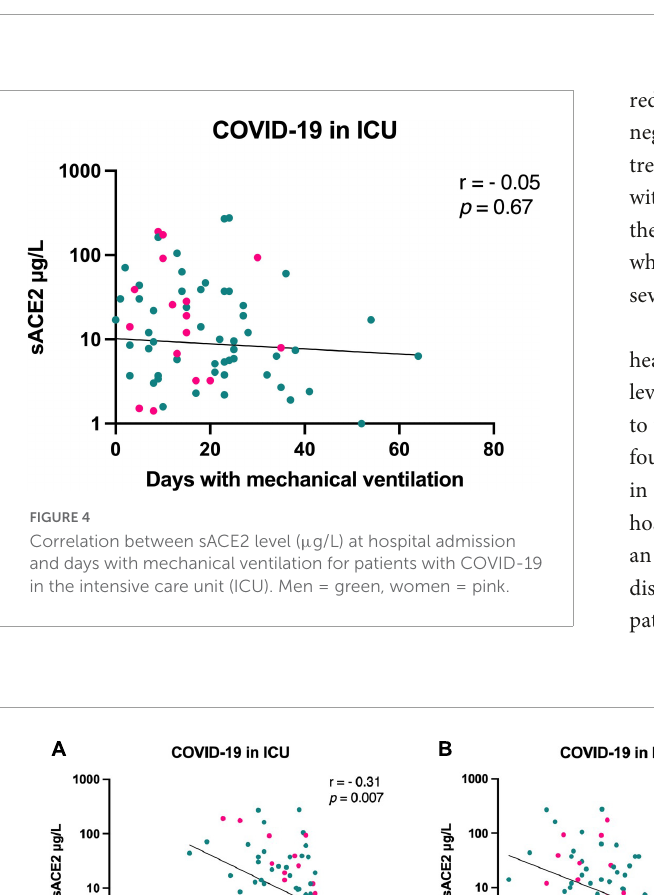
FIGURE3 Longitudinal measurements of sACE2 ( µ g/L) in patients with moderate COVID-19 ( n = 19) (A) and with COVID-19 requiring intensive care ( n = 104) (B) . Men = green, women = pink (ICU, intensive care unit).